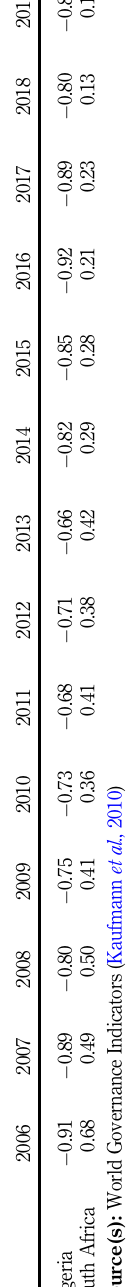
Table 1. The estimate of regulatory quality in Nigeria and South Africa between 2006 and